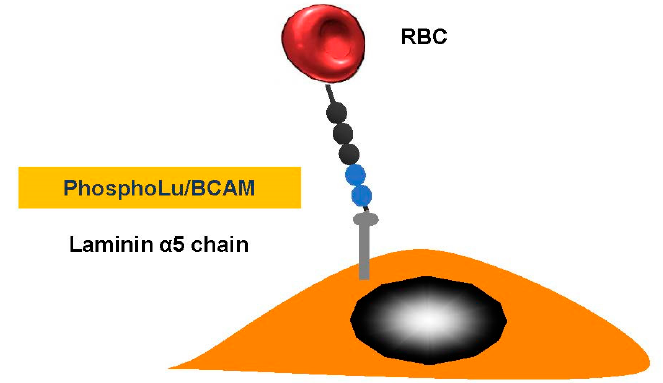
Figure 3. Polycythemia vera. Erythrocyte-phosphorylated Lu / BCAM can be found in people with